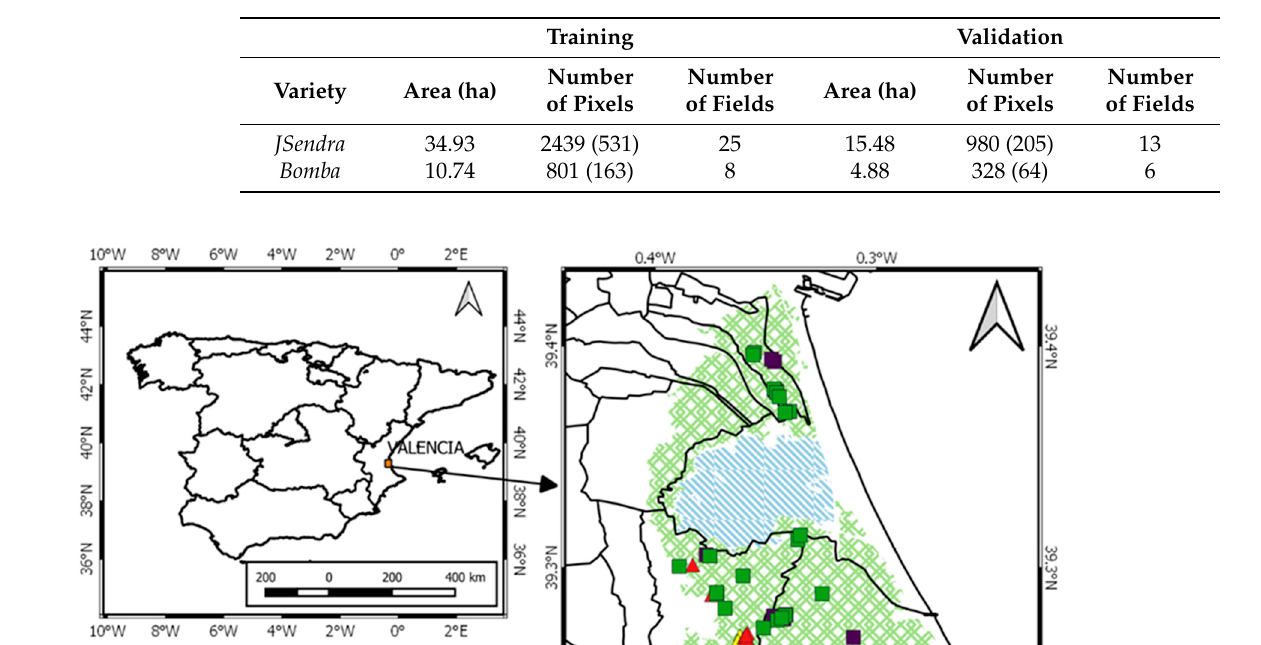
Table 3. Field data dissemination to build and evaluate the algorithms (the number of pixels was obtained at 10 m (20 m in parenthesis)).